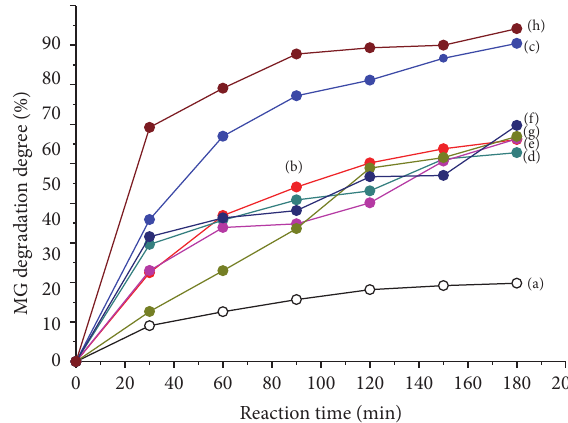
Figure 11: Photocatalytic degradation of malachite green dye during thefirst180minutesofreactiontime(a)withoutcatalyst(photolysis) and the photocatalytic process using (b) commercial V 2 O 5 , (c) synthesized V 2 O 5 , (d) V 2 O 5 -1Ag, (e) V 2 O 5 -5Ag, (f) V 2 O 5 -10Ag,